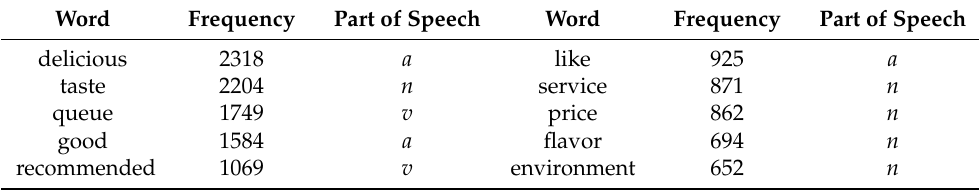
Table 6. Word frequency statistics and part of speech tagging of pre COVID-19 comments.